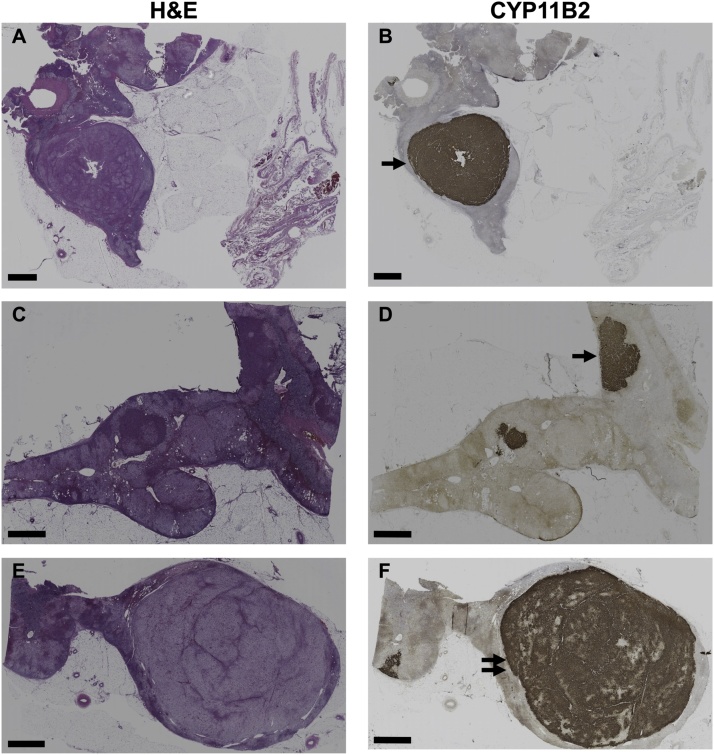
CYP11B2 immunohistochemistry micro-APA and macro-APA.The histopathology of resected adrenals from patients with a micro-APA (Panels A, B, C and D) or a macro-APA (Panels E and F) are shown with hematoxylin and eosin (H&E) staining (Panels A, C and E) and CYP11B2 immunostaining (Panels B, D and F). Micro-APAs in this study were classfied as a single micro-APA (diameter < 10 mm, as indicated by a single arrow in panel B) or the largest CYP11B2 positive nodule (with diameter < 10 mm, as indicated by a single arrow in panel D) in an adrenal with more than one nodule with CYP11B2 immunostaining. An example of a macro-APA is indicated with a double arrow in panel F. Scale bar = 2 mm. CYP11B2, aldosterone synthase; H&E, hematoxylin and eosin.